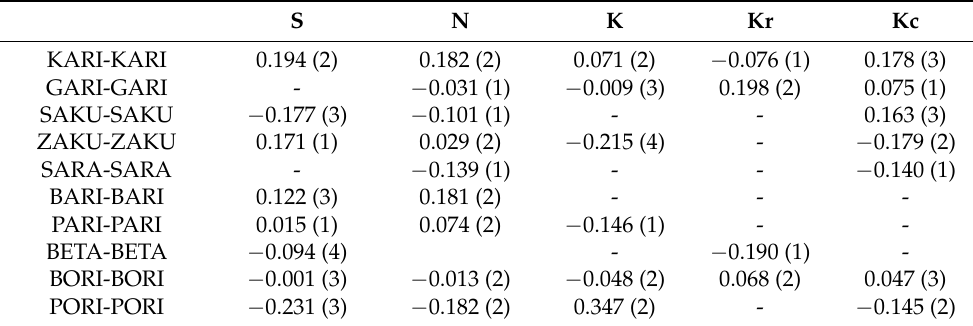
Table 1. Temporal drivers of liking in Experiment 1. Samples S, K, and N are available commercially and produced by different manufactures. Sample Kr was a moisturized and re-dried version of K, and Kc was a crushed version of K. The numbers in parentheses indicate the numbers of participants who chose the corresponding descriptor during product evaluation.